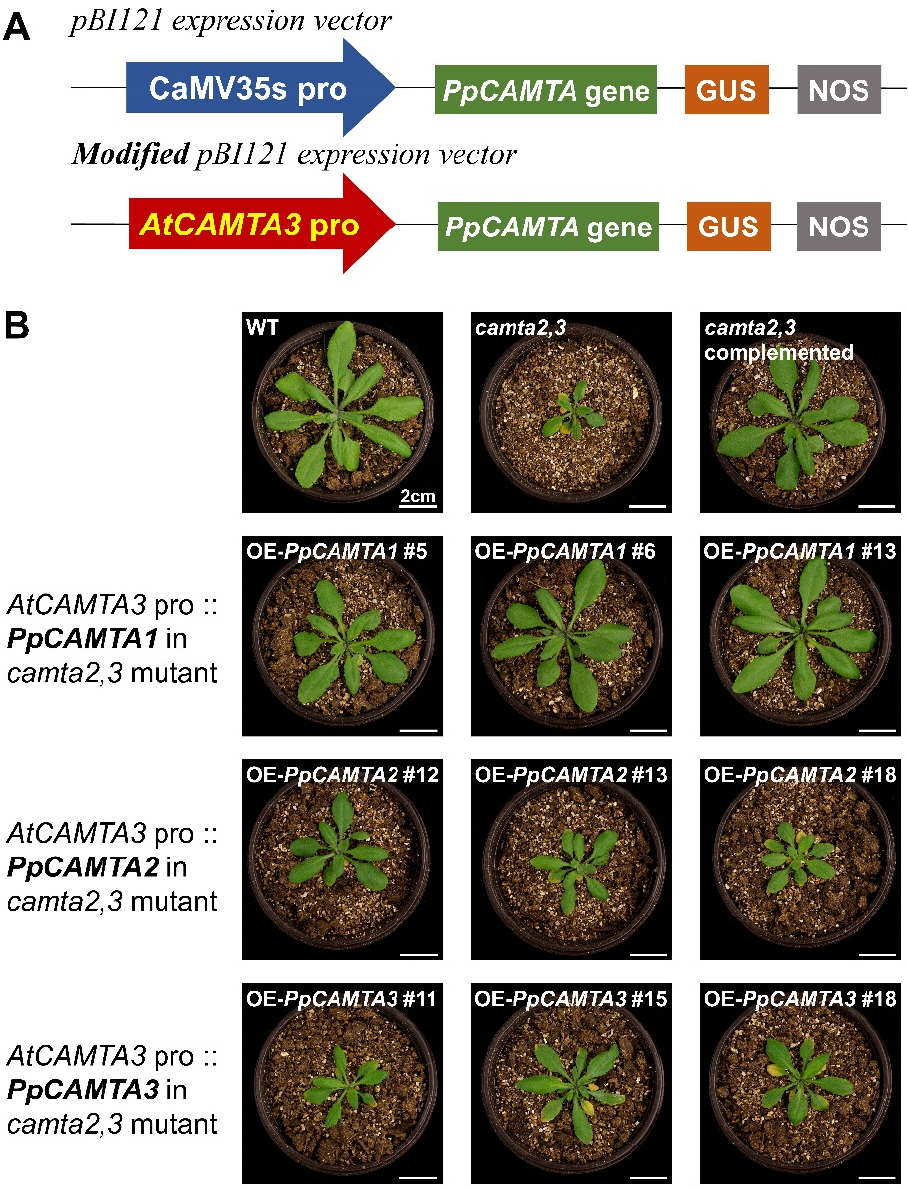
Figure 7. Overexpression of PpCAMTA1/2/3 in Arabidopsis camta2,3 mutant. ( A ) Schematic diagram of modified vector. ( B ) Photographs of the indicated plants grown at 22 °C for 28 days. WT: wild type; camta2,3 : double mutant of camta2 and camta3 ; OE -PpCAMTA1 , OE -PpCAMTA2 and OE -PpCAMTA3 : overexpression of PpCAMTA1, PpCAMTA2 and PpCAMTA3 in the background of Arabidopsis camta2,3 mutant driven by AtCAMTA3 promoter, respectively.